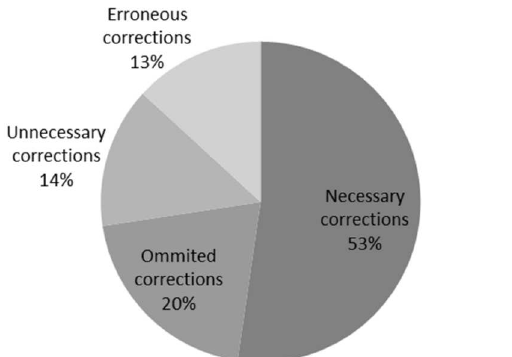
Figure 4. Corrections of the English MT